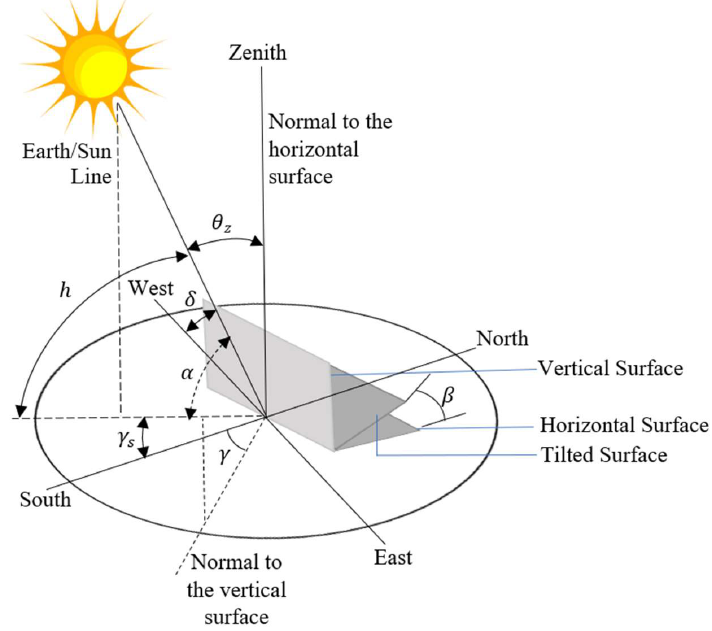
Figure 2. Solar Angles.